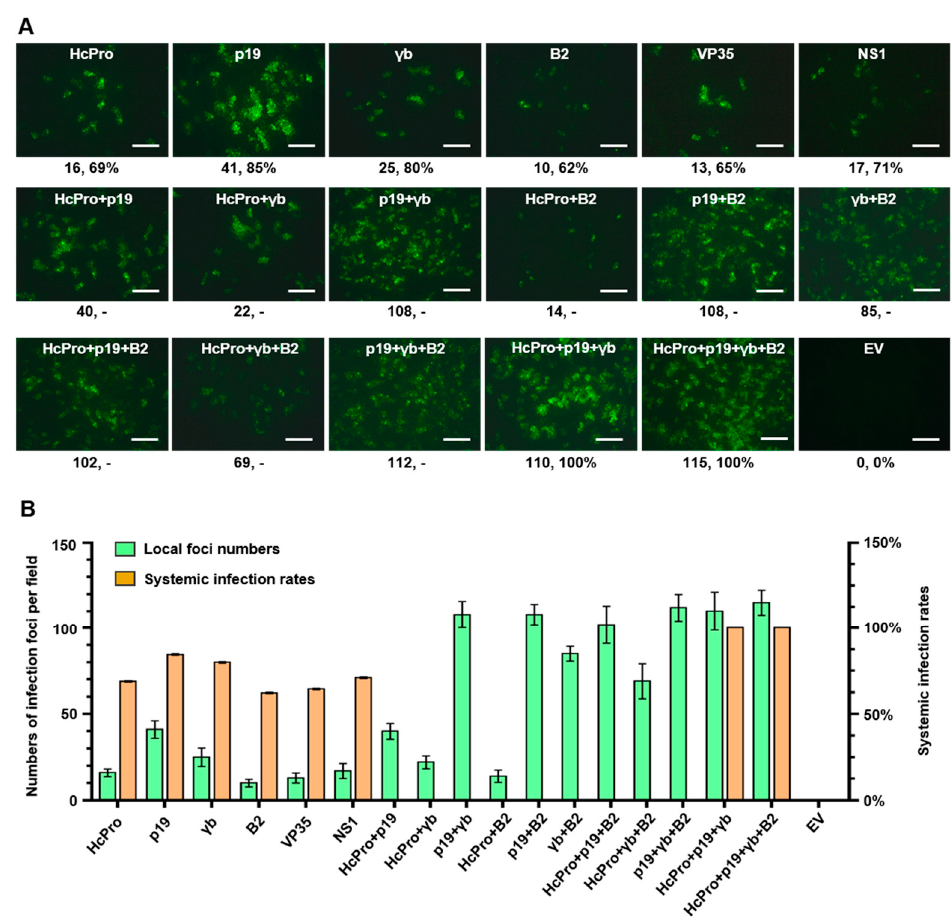
Figure 3. E ff ects of various co-expressed RNA silencing suppressors on SYNV rescue from a genomic cDNA clone. ( A ) Fluorescent microscope images showing the GFP foci in infiltrated leaves. N. benthamiana leaves were agroinfiltrated with bacterial cultures harboring the genomic cDNA clone pSYNV-GFP(-) and the supporting plasmids for expression of viral core proteins and a single or combinatory RNAi suppressors. GFP foci in agroinfiltrated leaf tissues were photographed with a fluorescence microscope at 9 dpi. The numbers (#, #%) below each panel are the average number of infection foci per field in infiltrated leaves at 9 dpi and the percentage of systemically infected plants per total agroinfiltrated plants at 30 dpi. Scale bar = 500 µ M. ( B ) Bar chart summarizing the e ffi ciencies of the local and systemic recovery of recombinant SYNV. Data are the means of three biological replicates for foci number counting and of three independent inoculation experiments for the calculation of systemic infection rates. Bars represent standard deviations. -, not determined. EV, empty binary